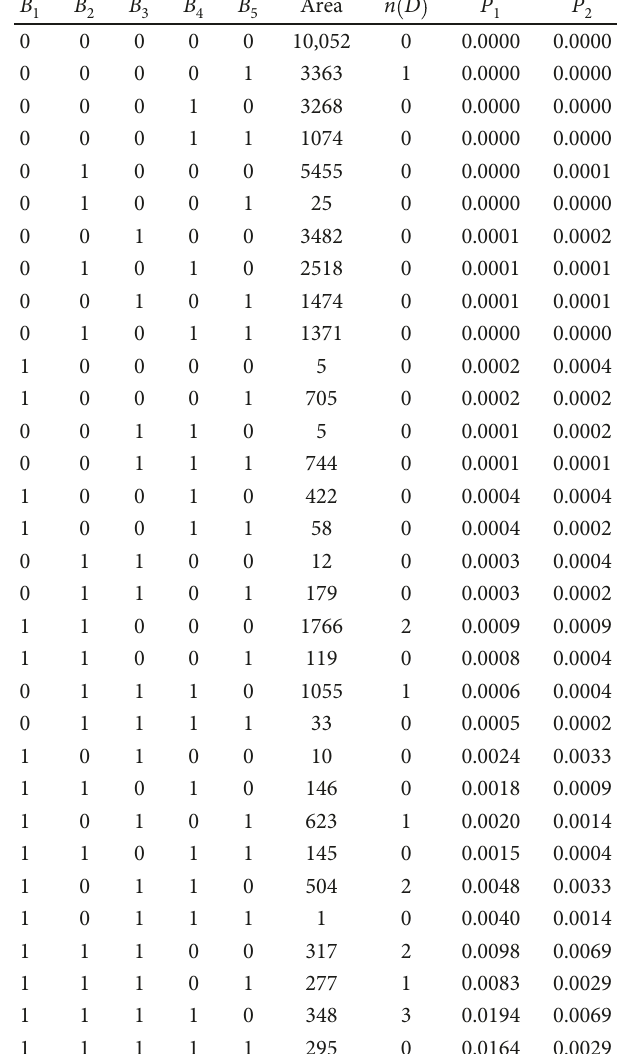
Table 3: Probabilities estimated for Agterberg et al. [11] sea fl oor example. Five binary predictors B ( i = 1, 2, … , 5 ) are for age, i topography, contact between youngest volcanics, rock type, and fi ssures, respectively. Area of unique condition is given in units of